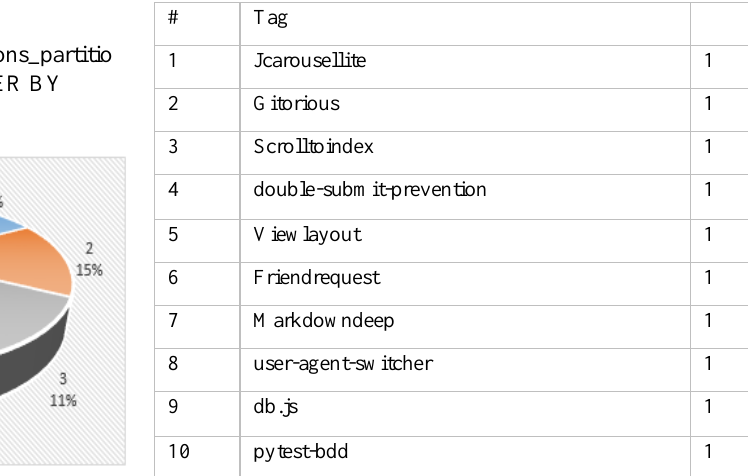
Figure 6. Pie charts to show 'JavaScript' tag occurrences with other tags